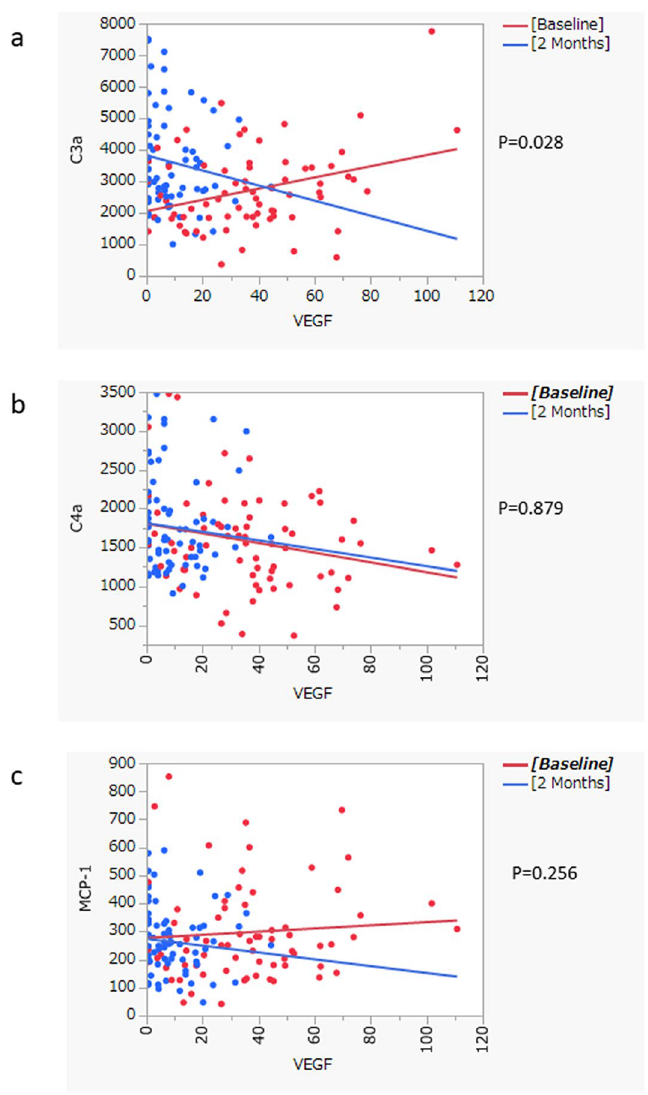
Figure 2. Analyses of covariance. Red dot: baseline. Blue dot: 2 months. The correlation between VEGF and C3a levels ( a ) is statistically different between baseline and 2 months ( P = 0.028). There was no difference in C4a ( b ) and MCP-1 levels ( c ).